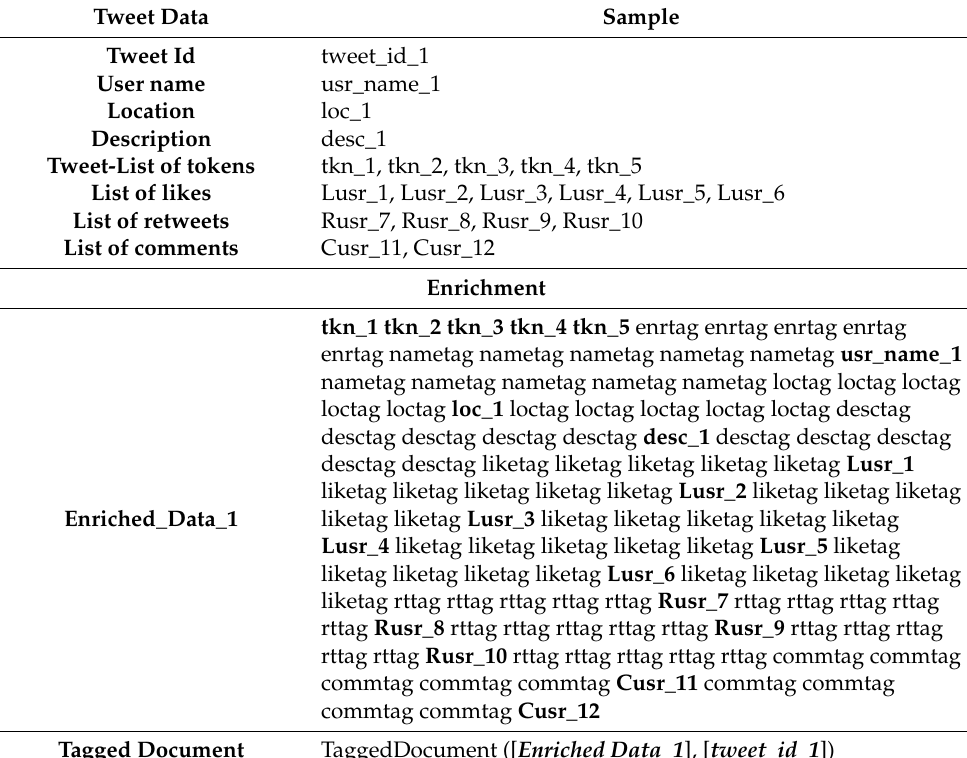
Table 6. Enrichment with dummy tokens.